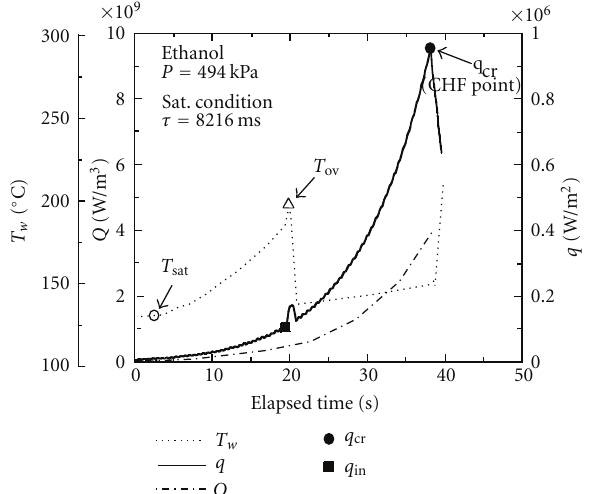
Figure 2: Illustrative time traces of heat generation rate, Q ; wall temperature of wire, T w ; and heat flux, q .